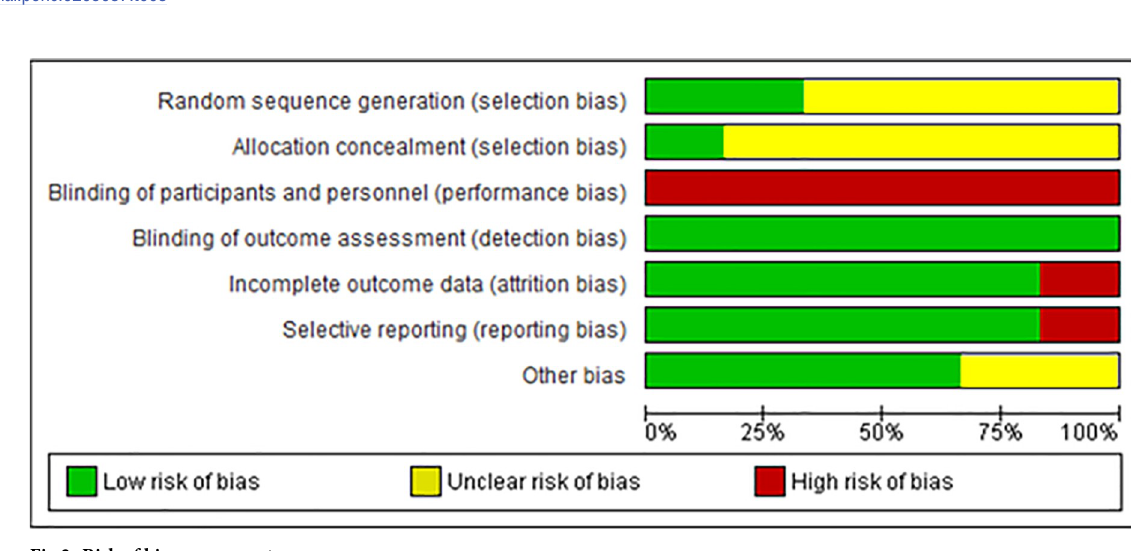
Description of the selected randomized clinical trials and the age of the participants at baseline. Mean ± SD † Primary outcome.